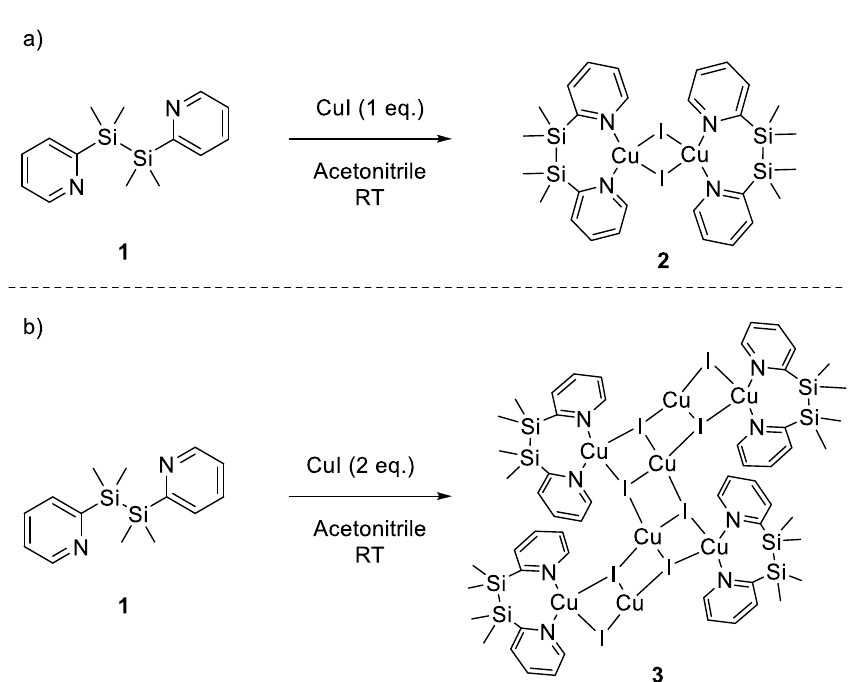
Figure 1. ORTEP drawing of complex 2 with thermal ellipsoids at the 50% probability level. Hy- drogen atoms were omitted for clarity. Selected bond lengths and angles. Cu…Cu′ : 3.8761(3) Å . Cu‒I: 2.7405(3) Å. Cu‒I′: 2.9689(3) Å. I…I′: 4.1982(3) Å. Cu‒N1: 1.987(2) Å. Cu‒N2: 1.993(2) Å. Si1‒ Si2: 2.3441(7) Å. Cu…Si1: 3.3453(5) Å. Cu…Si2: 3.2611(5) Å. Cu‒I‒Cu′: 85.417(7)°. I‒Cu‒I′ : 94.583(7)°. N1‒Cu‒N2: 140.45(6)° .